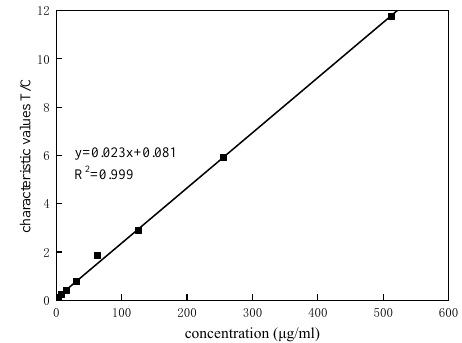
Figure 9. Linearity of the detection results after automatic range adjustment.